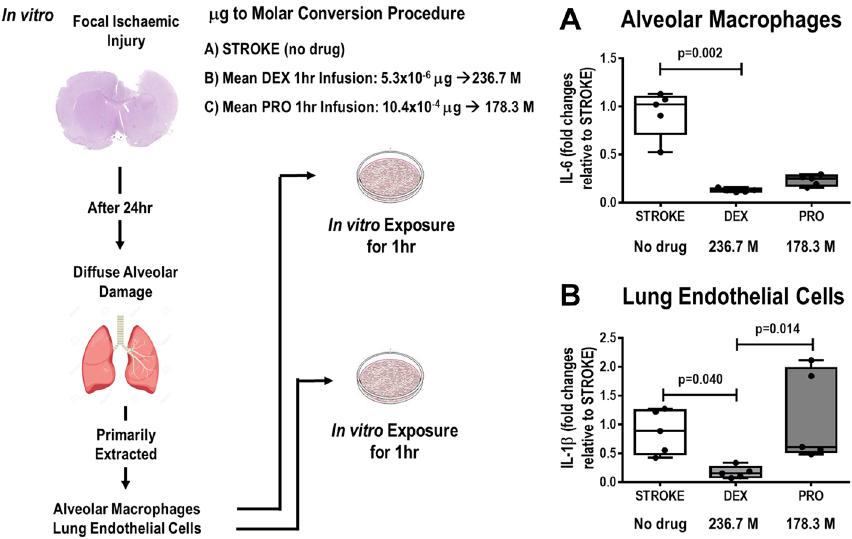
Figure 4. Overall in vivo and in vitro experimental scheme. Left: For the in vivo experiments, in order to obtain comparable work of breathing and mean arterial pressure, different total drug infusion concentrations of dexmedetomidine and propofol were infused (mean values from 10 animals: 5.3 × 10 –6 μg, and 10.4 × 10 – 4 μg, respectively). Right: For the in vitro experiments, the total drug infusion concentrations of both dexmedetomidine and propofol were converted to respective plasma molarity (236.7 M and 178.3 M). An additional 5 male Wistar rats were subjected to focal ischemic stroke; 24 h later, alveolar macrophages and lung endothelial cells were primarily extracted, cultured, and, after achieving 80% confluence, exposed to similar amounts of dexmedetomidine and propofol as used in the in vivo experiments. Gene expressions of IL-6 in alveolar macrophage ( A ) and IL-1β in lung endothelial cells ( B ) in the STROKE, DEX, and PRO groups were evaluated after 1 h of exposure, the same time used for the in vivo experiments. No difference was observed between PRO versus STROKE ( p = 0.198) and PRO versus DEX ( p = 0.312) in relation to IL-6 in alveolar macrophages. No difference was observed between PRO versus STROKE ( p = 0.999) in relation to IL-1β in lung endothelial cells. Box plots represent the median and interquartile range of 5 animals in each group. Comparisons done by Kruskal–Wallis test followed by Dunn’s multiple comparisons test ( p <